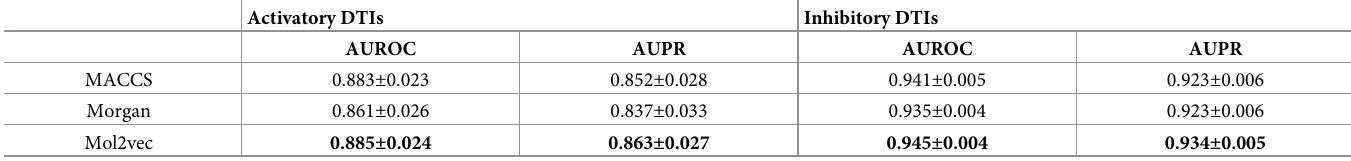
Table 3. Assessment of performance across compound embedding